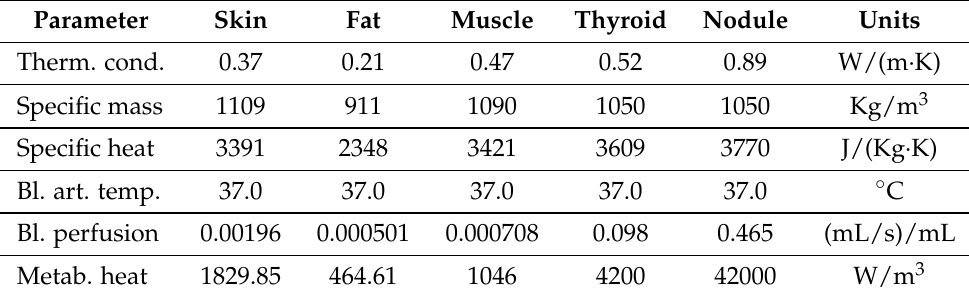
Table 1. Tissue thermophysical parameters used in numerical